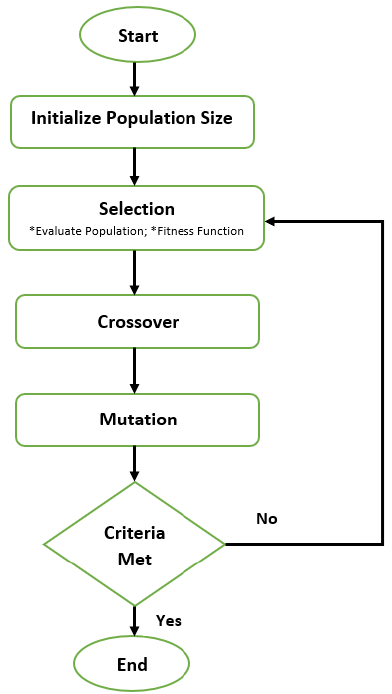
Figure 3. Standard Genetic Algorithm Process.